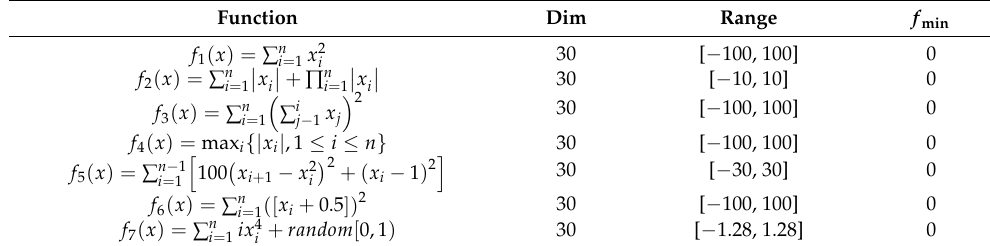
Table 1. Description of unimodal benchmark functions.